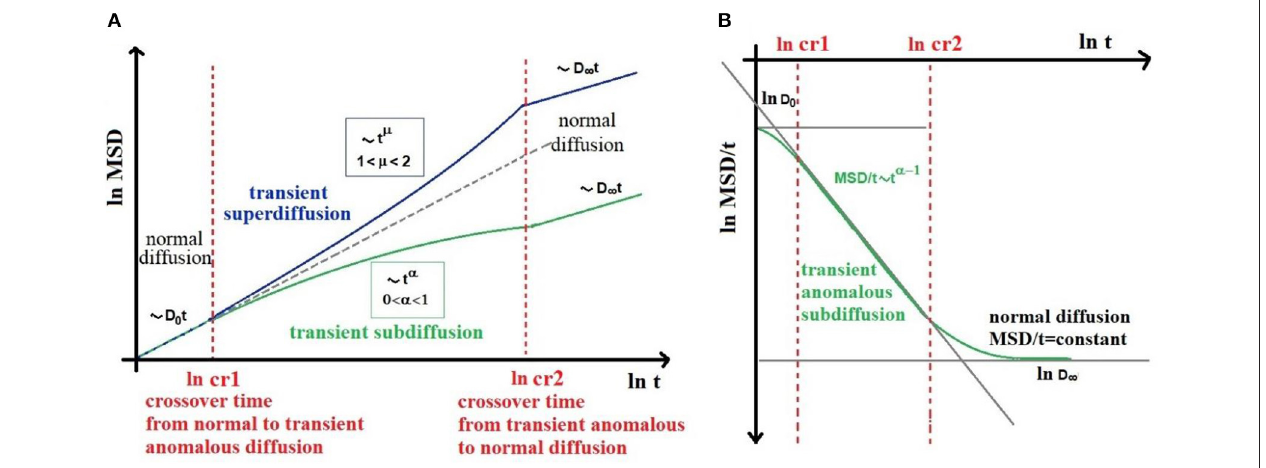
FIGURE 2 | Schematic representation of MSD (A) and D(t) (B) behavior in high heterogeneous complex biological tissues, showing transient anomalous diffusion (AD). AD exists between two crossover times (cr1 and cr2). For t < cr1, i.e., at very short diffusion times we find normal diffusion characterized by D = D 0 , while for t > cr2, i.e., at long diffusion times, we still find normal diffusion, defined by a finite value of D = D ∞ . The (cr1, cr2) time interval, must be long enough to include at least three orders of magnitude over time. As an example in AD MRI, the diffusion time 1 should run from 5 to 500ms.